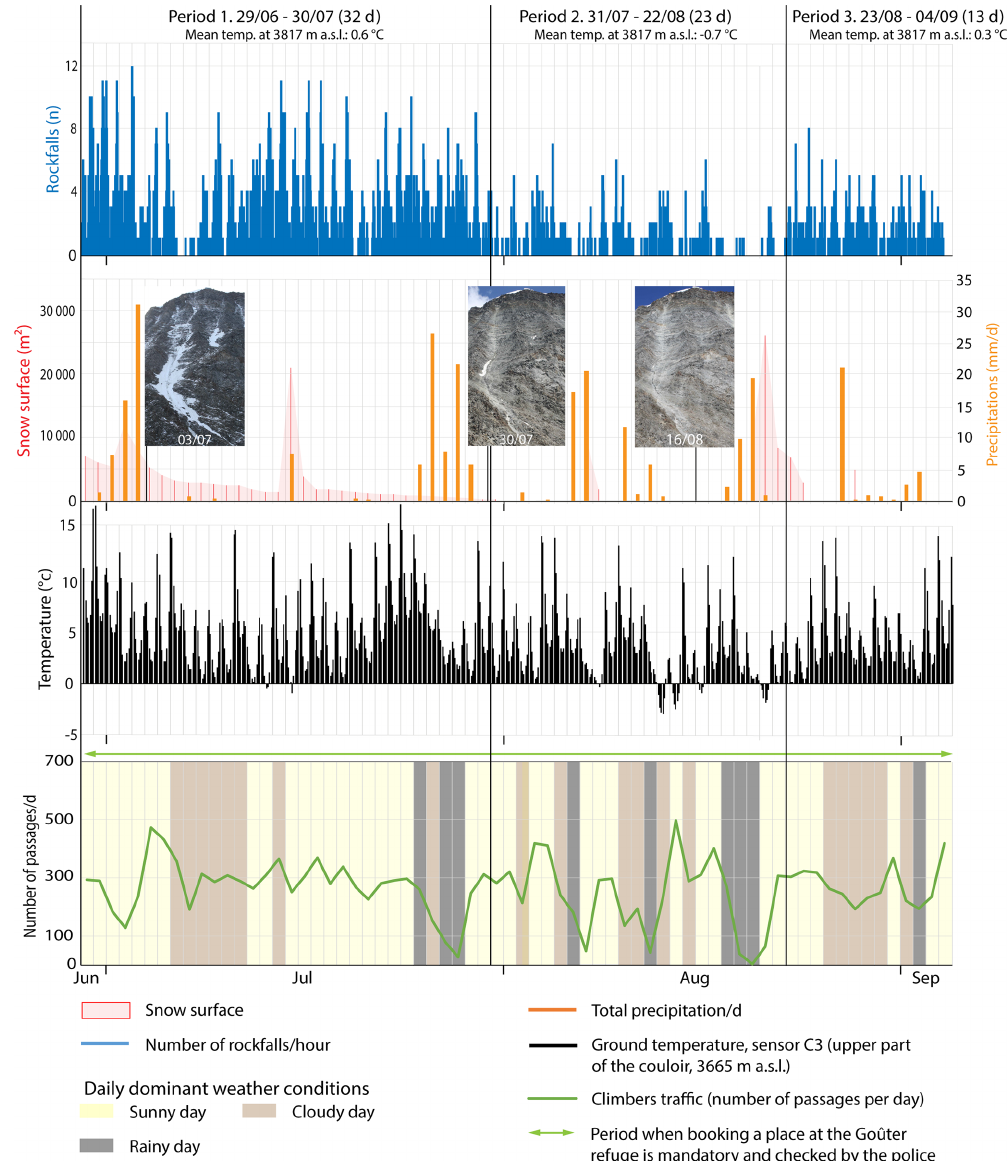
Figure 6. Comparison between the number of rockfalls per hour, the evolution of the snow-covered surface, precipitation, ground temperature on the upper part of the couloir (sensor C3) and the daily variation in climber traffic during summer 2019. The images, which were taken with the automatic camera (Sect. 4.2), allowed the evolution of the snow cover in the couloir to be studied.